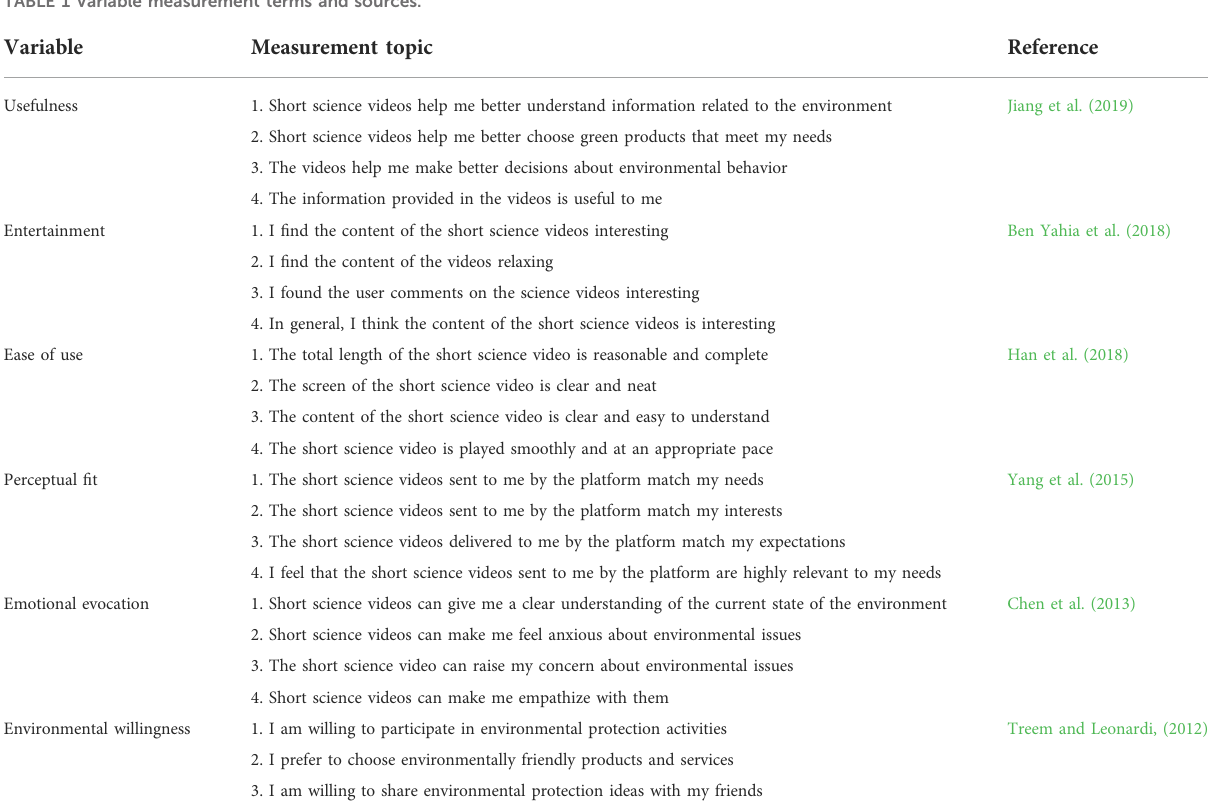
FIGURE 1 Framework of this study.